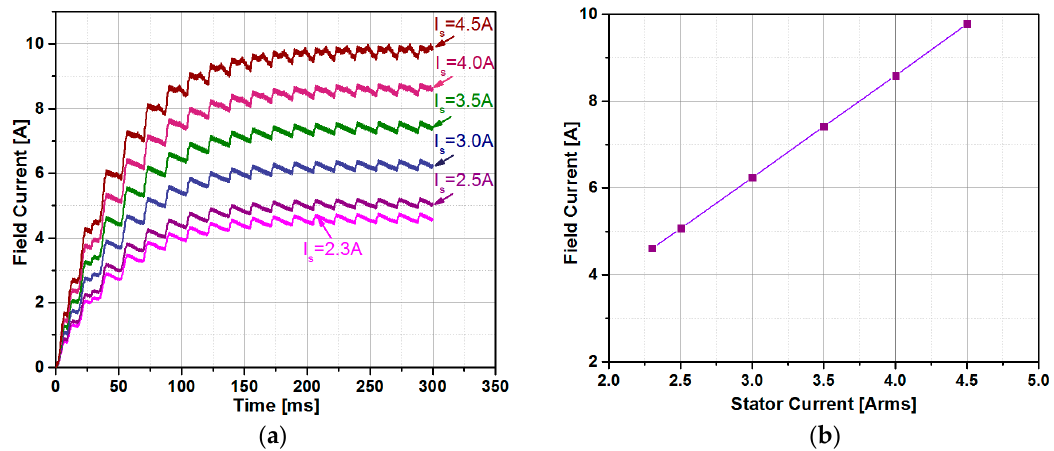
Figure 15. Variation of field current with stator current: ( a ) waveform; and ( b ) average values. Energies 2018 , 11 , x FOR PEER REVIEW